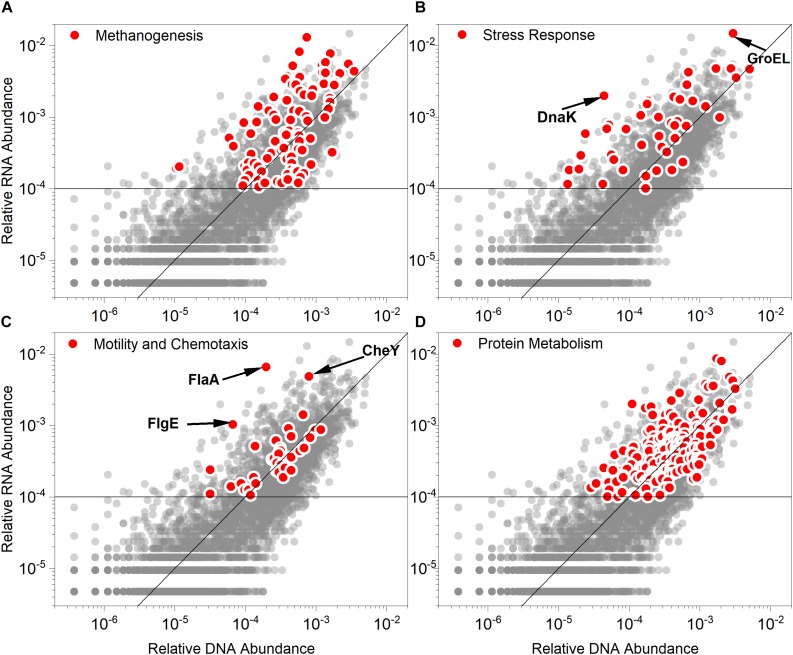
Relative abundance values of the gene (DNA) and corresponding transcript (RNA) in the (A) methanogenesis, (B) stress response, (C) motility and chemotaxis and (D) protein metabolism modules (red points). Each scatterplot illustrates the gene and transcript relative abundance based on Subsystem databases (gray points). The function line of y = x was graphed to distinguish between the overexpressed (points above the line, indicating RNA > DNA) and under-expressed genes (points below the line, indicating RNA < DNA). The horizontal line indicates that the relative RNA abundance was 0.01%. GroEL, heat shock protein family chaperone; DnaK chaperone protein; CheY, chemotaxis regulator and transmits chemoreceptor signals to flagellar motor component; FlaA, flagellin protein; FlgE, flagellar hook protein.